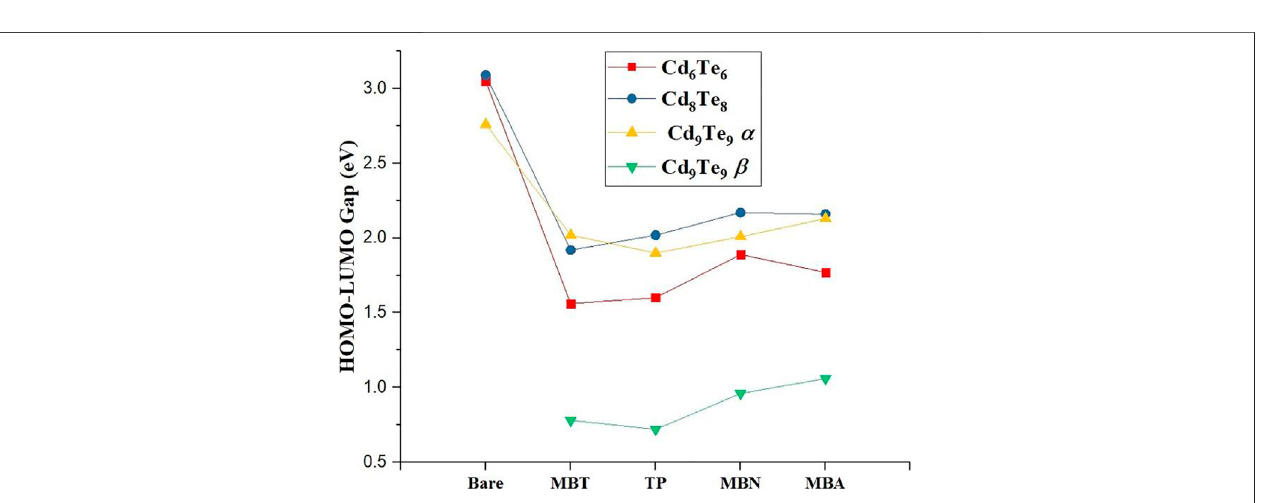
Frontiers in Materials |